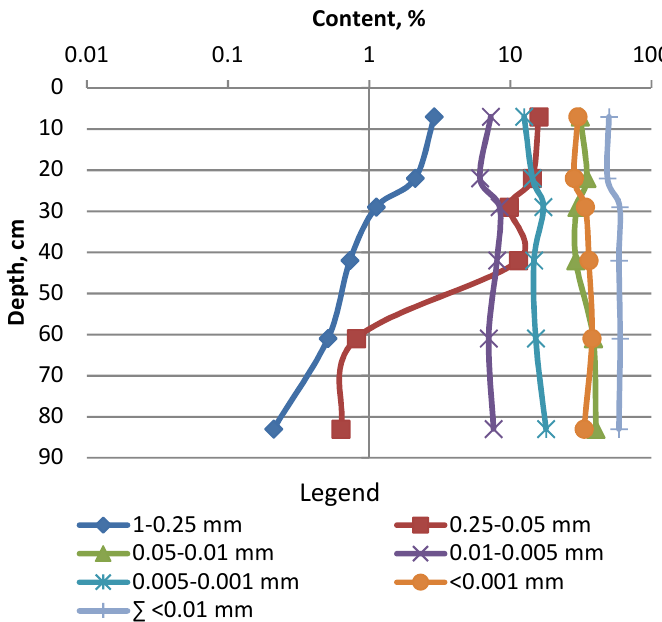
Figure 3. Profile distribution of fractions of mechanical elements in the Urbic Technosol Loamic, Eutric of the residential zone of Gubakha.